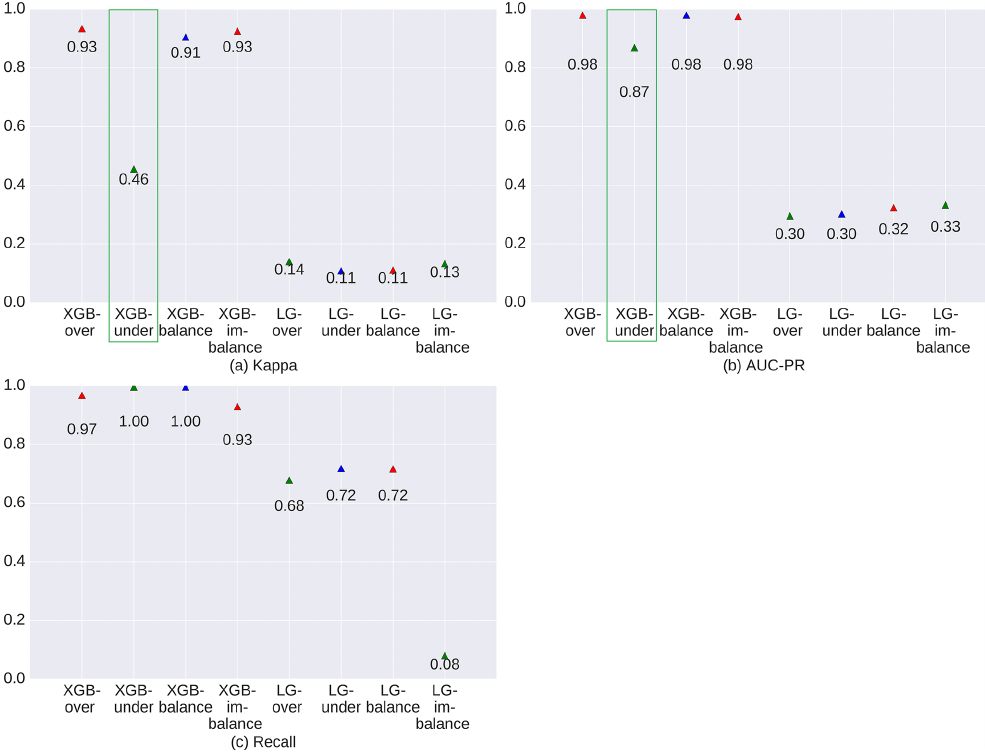
Note that the top rank indicates the most significant ef- fects across all predictions. Each point in the cloud to the left represents a row from the original dataset. The colour code denotes high (red) to low (blue) feature values. Positive SHAP values represent a higher likelihood of NGD, while negative values indicate lower likelihoods. The range across the SHAP value space indicates the degradation probability, expressed as the logarithm of the